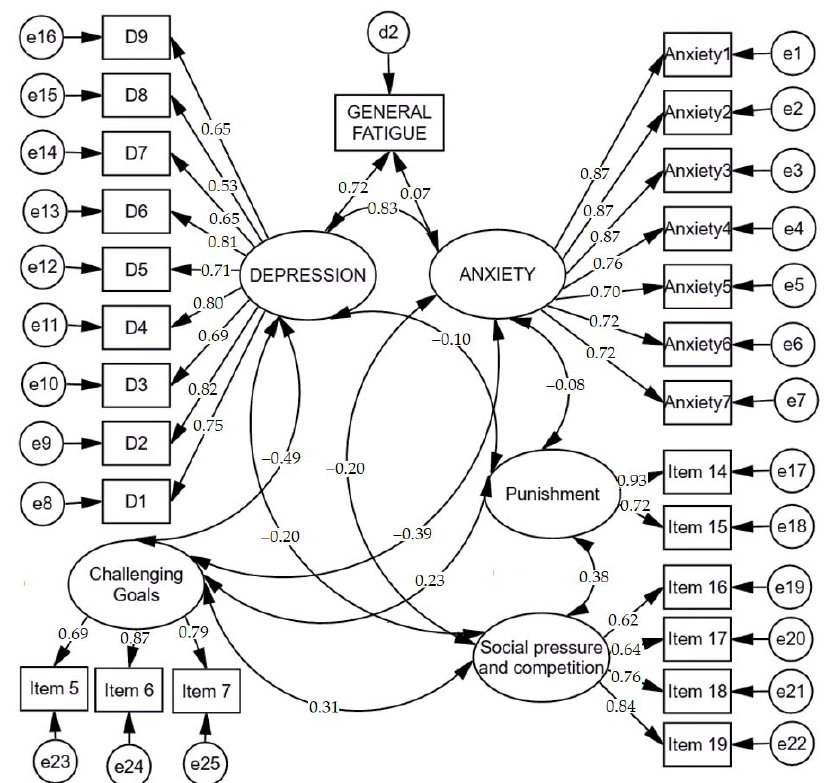
Figure 1. Standardized results on the model of associations between learning motivating factors (challenging goals, punishment, social pressure, and competition), anxiety, depression, and fatigue in the group of participants of e-learning-based computer programming courses. Table 15. Scalar estimates of the model of associations between learning motivating factors, anxiety, depression, and fatigue in the sample of participants of e-learning-based computer programming courses. programming courses are displayed in Table